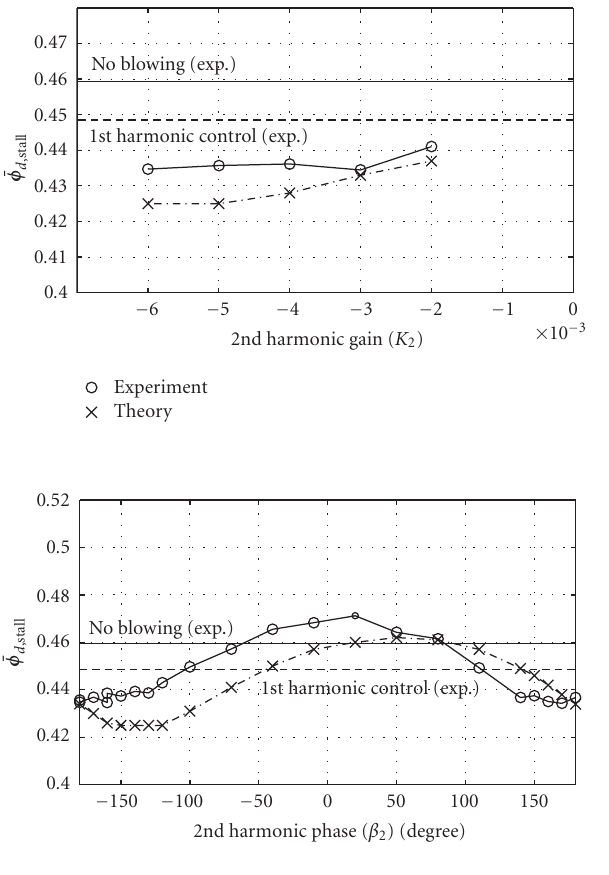
Figure 16: Experimental gain and phase optimization for second harmonic control. Top: gains = [ − 0 . 005, K 2 ,0] and phases = [ − 55 ◦ , − 180 ◦ ,0 ◦ ]. Bottom: gains = [ − 0 . 005, − 0 . 005,0] and phases = [ − 55 ◦ , β 2 ,0 ◦ ].